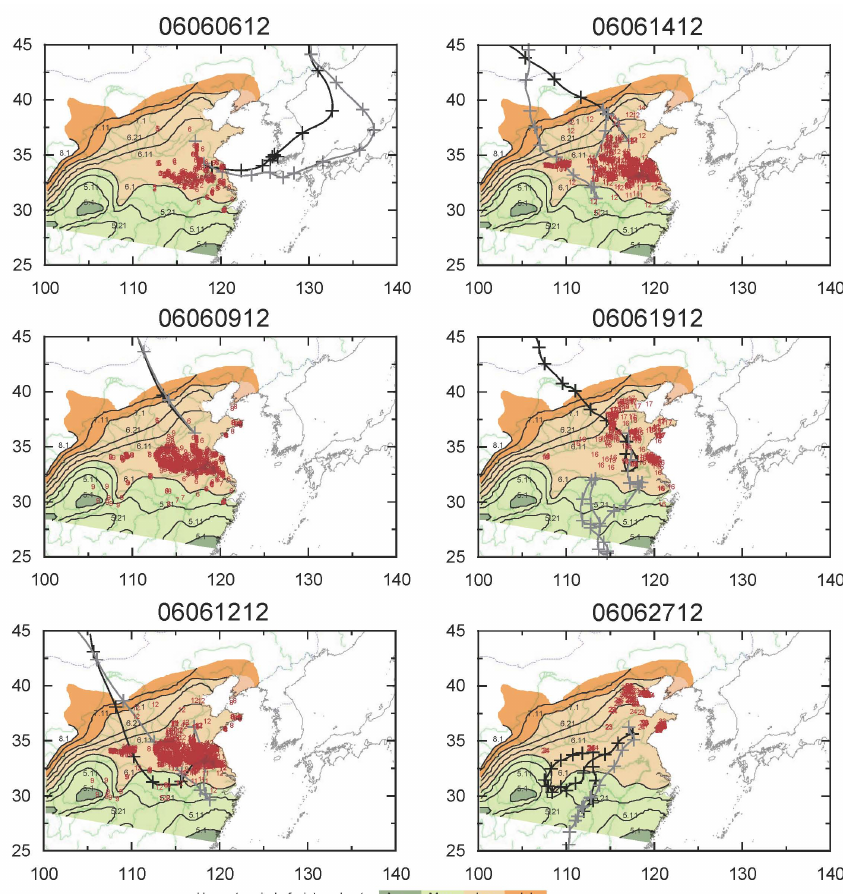
Fig. 8. Backward trajectories with starting altitudes of 1500 (black) and 750m (gray) at six different times (YYMMDDHH inLT, shown above individual panels). Plus marks indicate the locations of air mass every 12 h. Hotspots detected by satellite sensors during the 5 preceding days are shown in red (numbers indicate the detection day in June). Harvest areas of winter wheat in different months are shown by colored